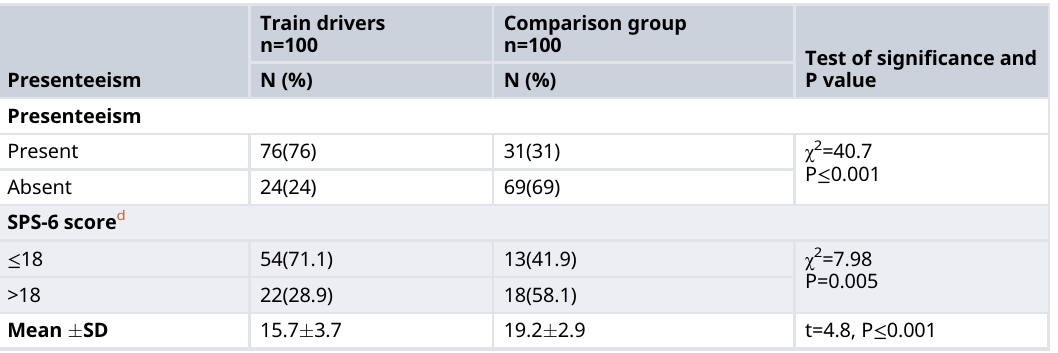
Table 4. Presenteeism among study groups measured by Stanford Presenteeism Scale